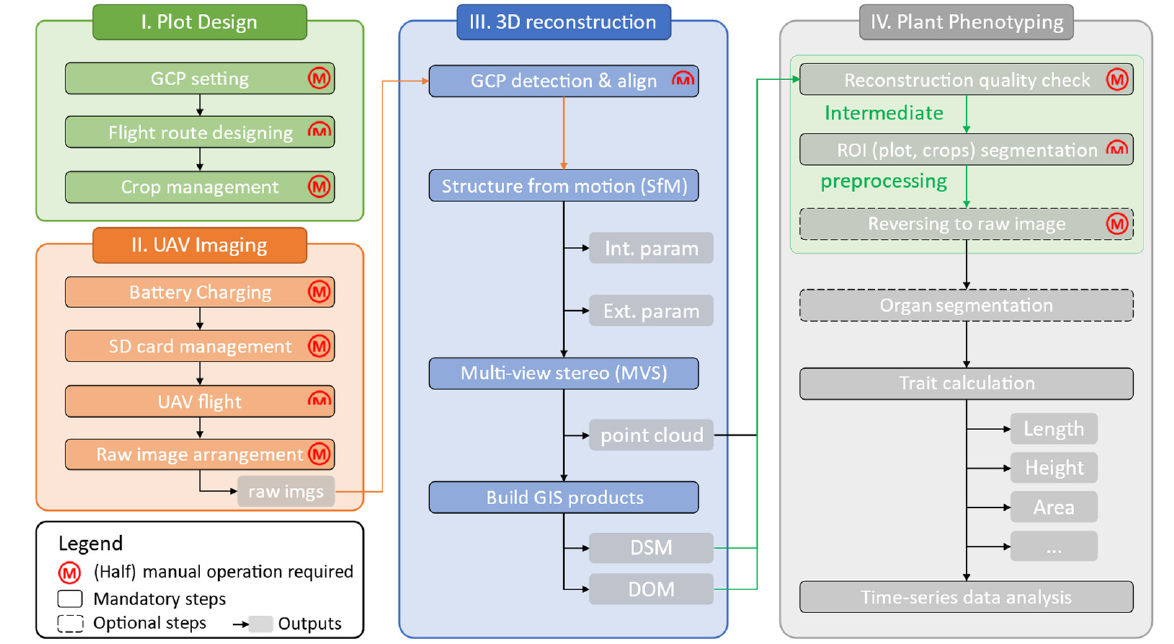
Figure 1. General workflow of UAV-based field plant phenotyping in agriculture. The developed tool focused on decreasing the workload of the intermediate data processing steps (green parts in IV). “Int. param” represents internal parameters (e.g., focal length), and “Ext. param” represents external parameters (e.g., camera position, rotation.). DSM represents the digital surface model, and DOM represents the digital orthomosaic.